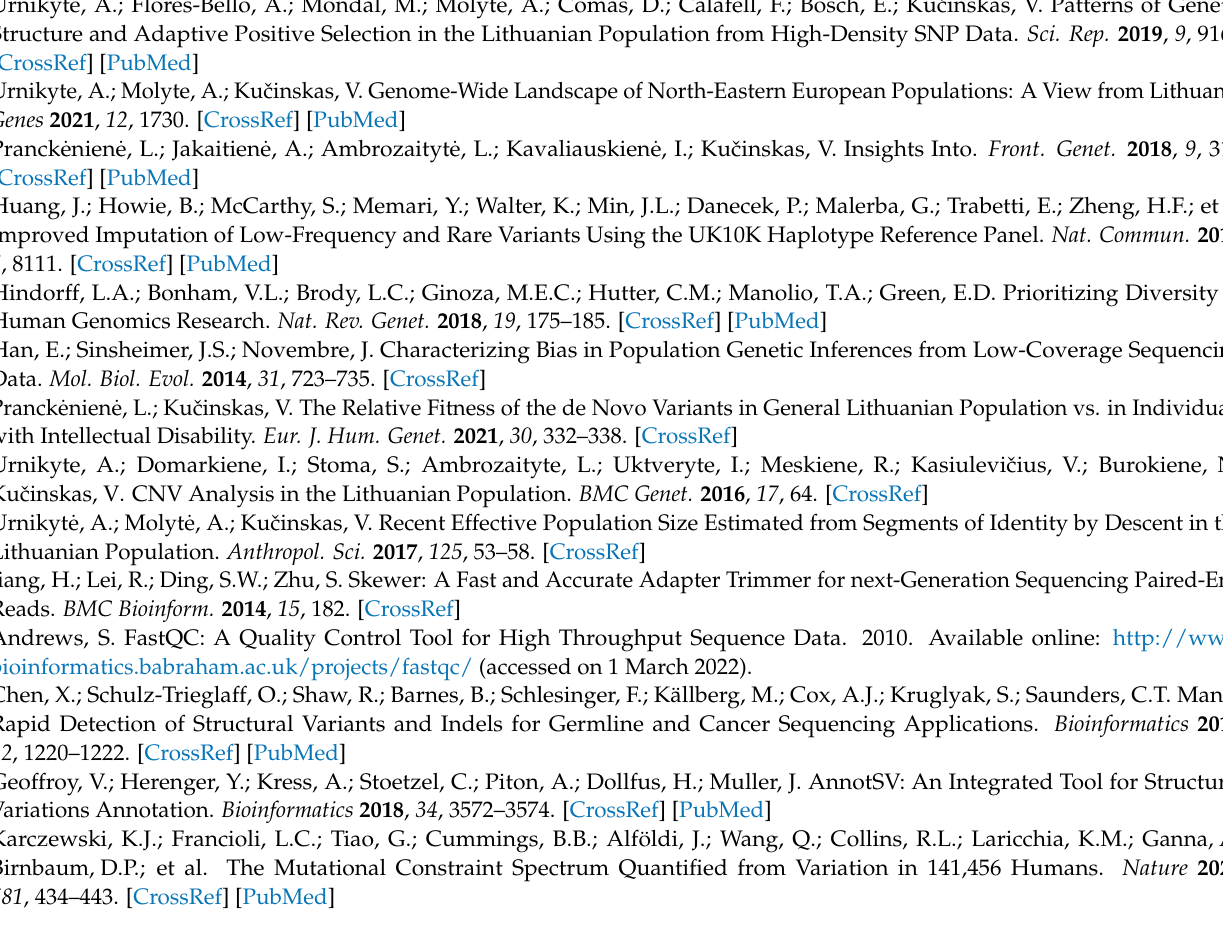
Table S5: Relatedness analysis performed for trios; Table S6: Detected outliers in our study. Author Contributions: Methodology, formal analysis and writing—original draft preparation,